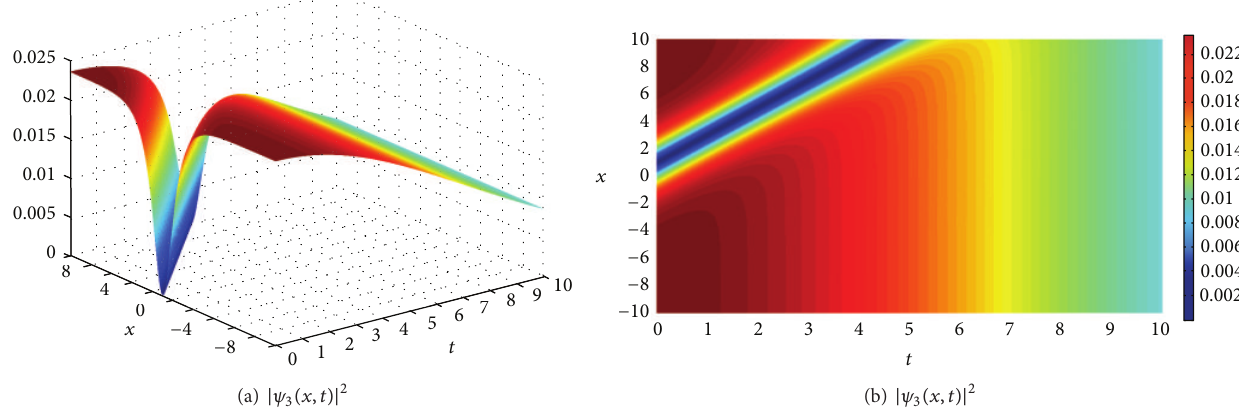
Figure 3: Density distributions of the matter-wave soliton solution 𝜓 3 (𝑥,𝑡) : (a) the three dimensional density distribution and (b) the contour